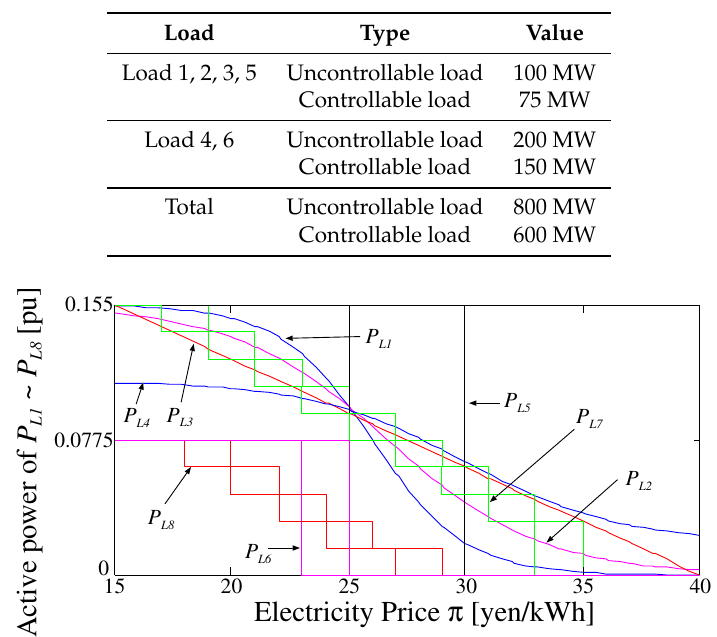
Figure 11. Power consumption of each controllable load for electricity price (Load 1, 2, 3,